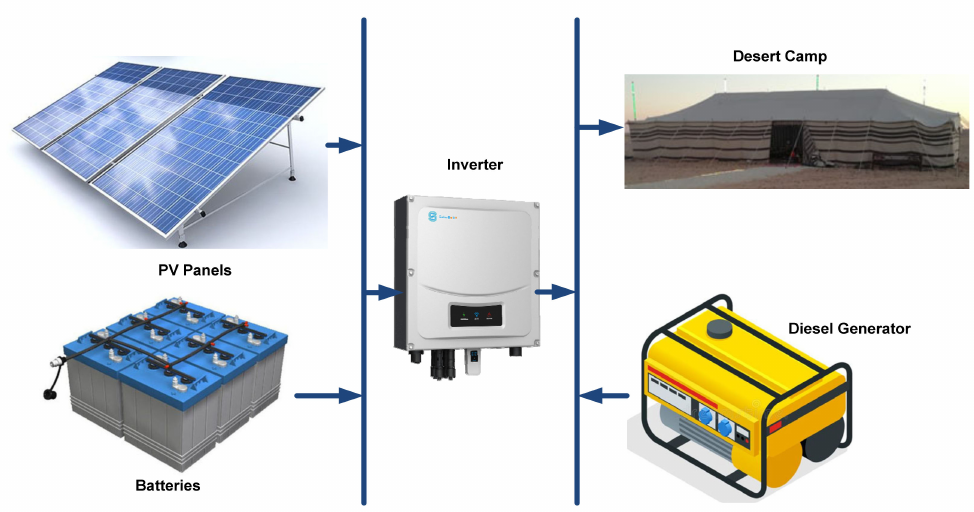
Figure 1. Standalone hybrid nanogrid for a desert camp.